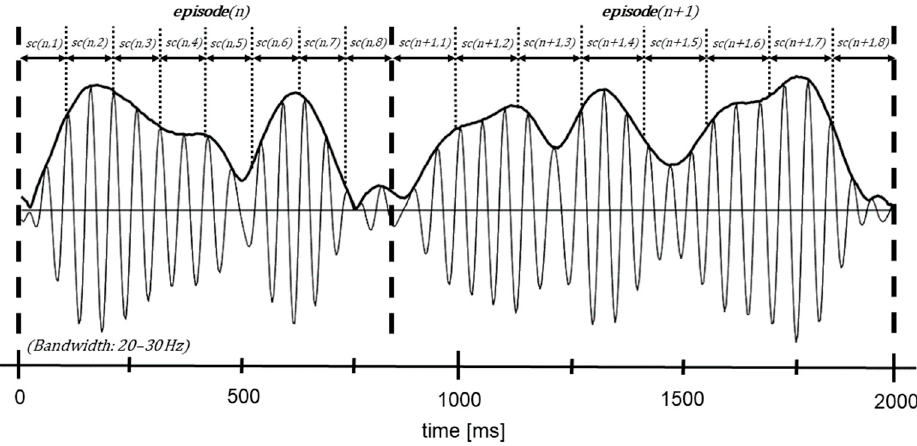
Figure 2. Divided episodes into eight equal sectors, where the episode length is different.